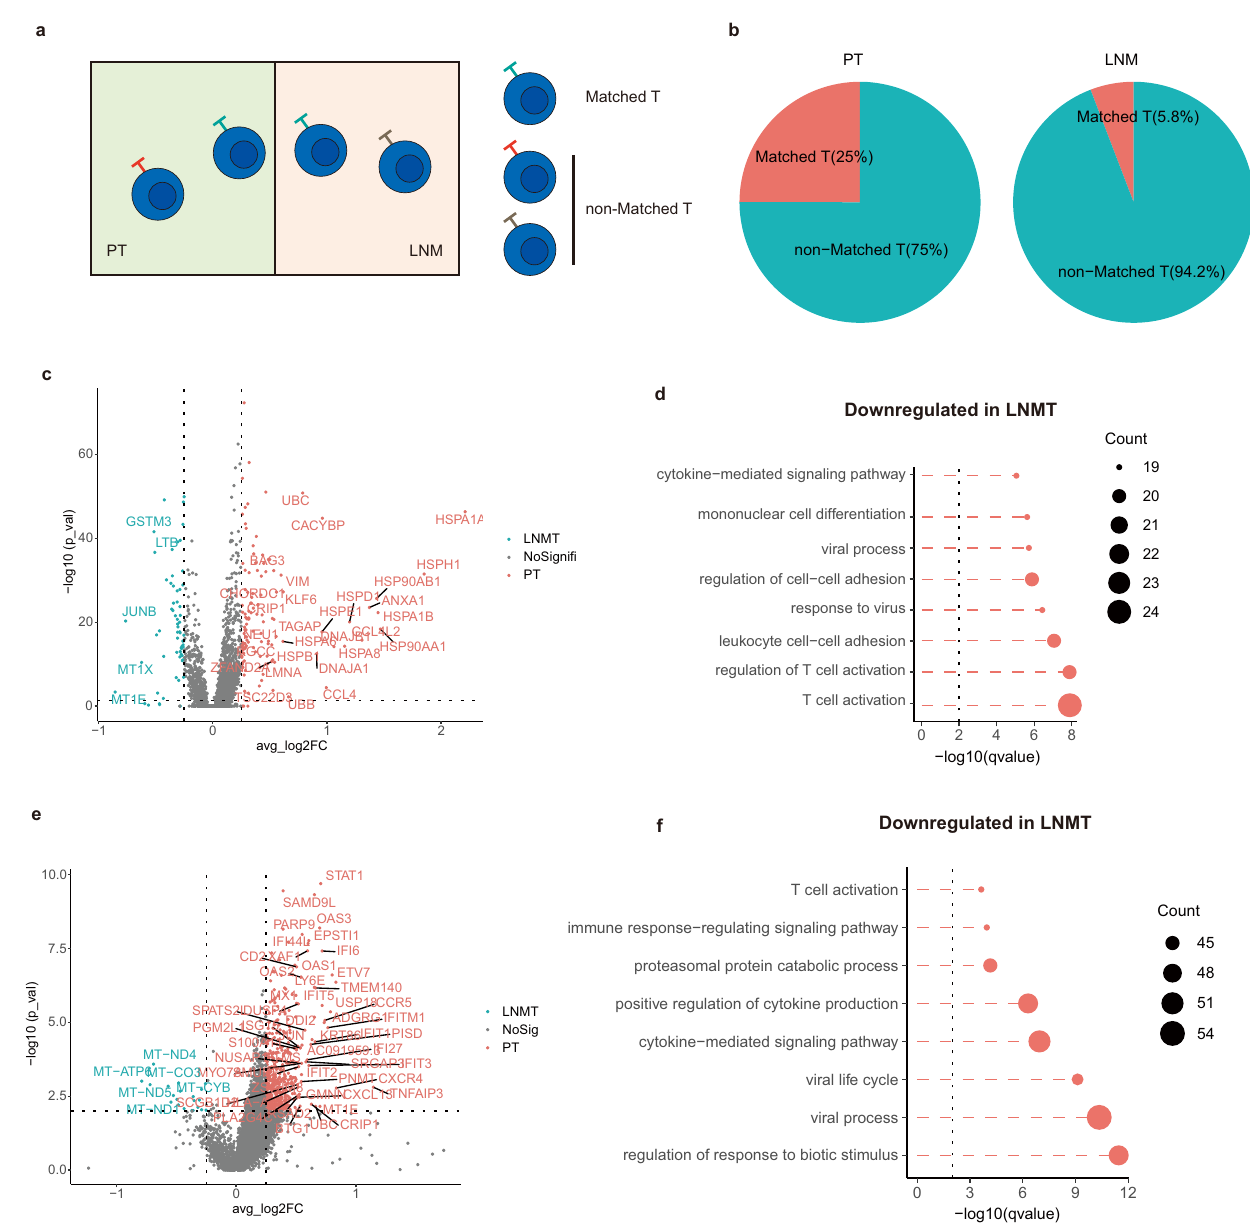
Fig. 4 | Characteristics of matched T cells in the breast cancer microenviron- ment. a Diagram of matched T and nonmatched T cells. b Pie charts showing the fraction of matched T and nonmatched T cells in PT (left) or LNMT (right). c Volcano plot showing differentially expressed genes between LNMT vs PT for matchedCD8Tcells. P value<0.05,log2(foldchange) ≥ 0.25.Statisticaltestingwas performed by a two-sided Wilcoxon test. d Top 8 enriched pathways for down- regulated genes of matched CD8 T cells in LNMT vs PT. Statistical testing was